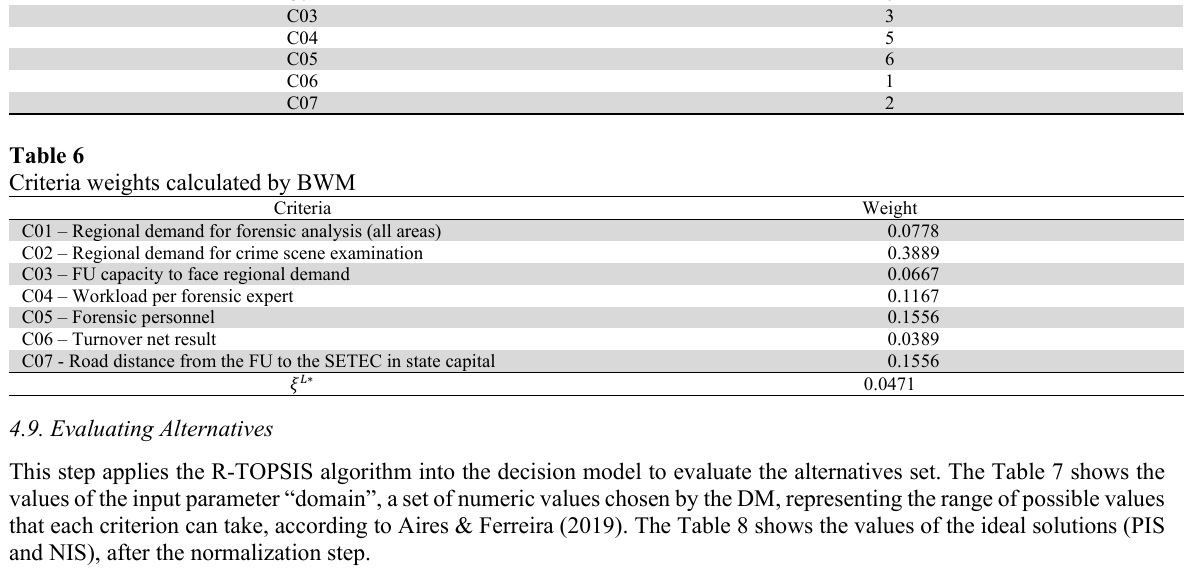
Pairwise comparison vector for the worst criterion Criteria